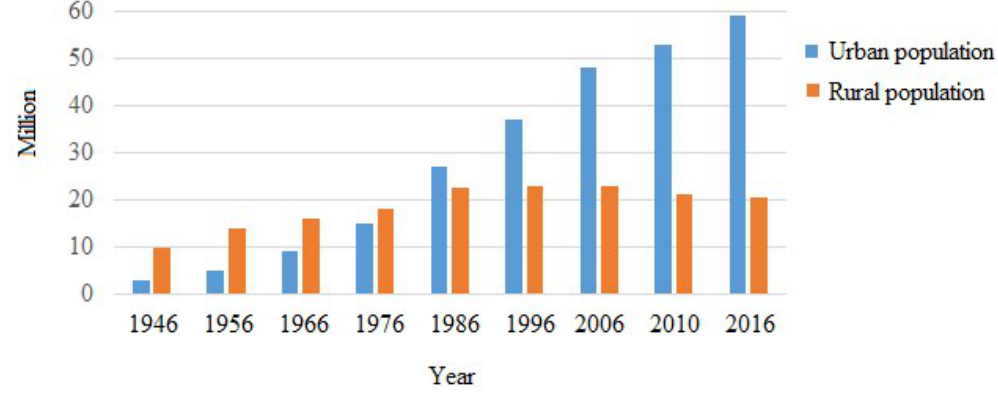
Figure 5. Iran’s population growth in urban and rural areas. Source: Statistical Centre of Iran [42].